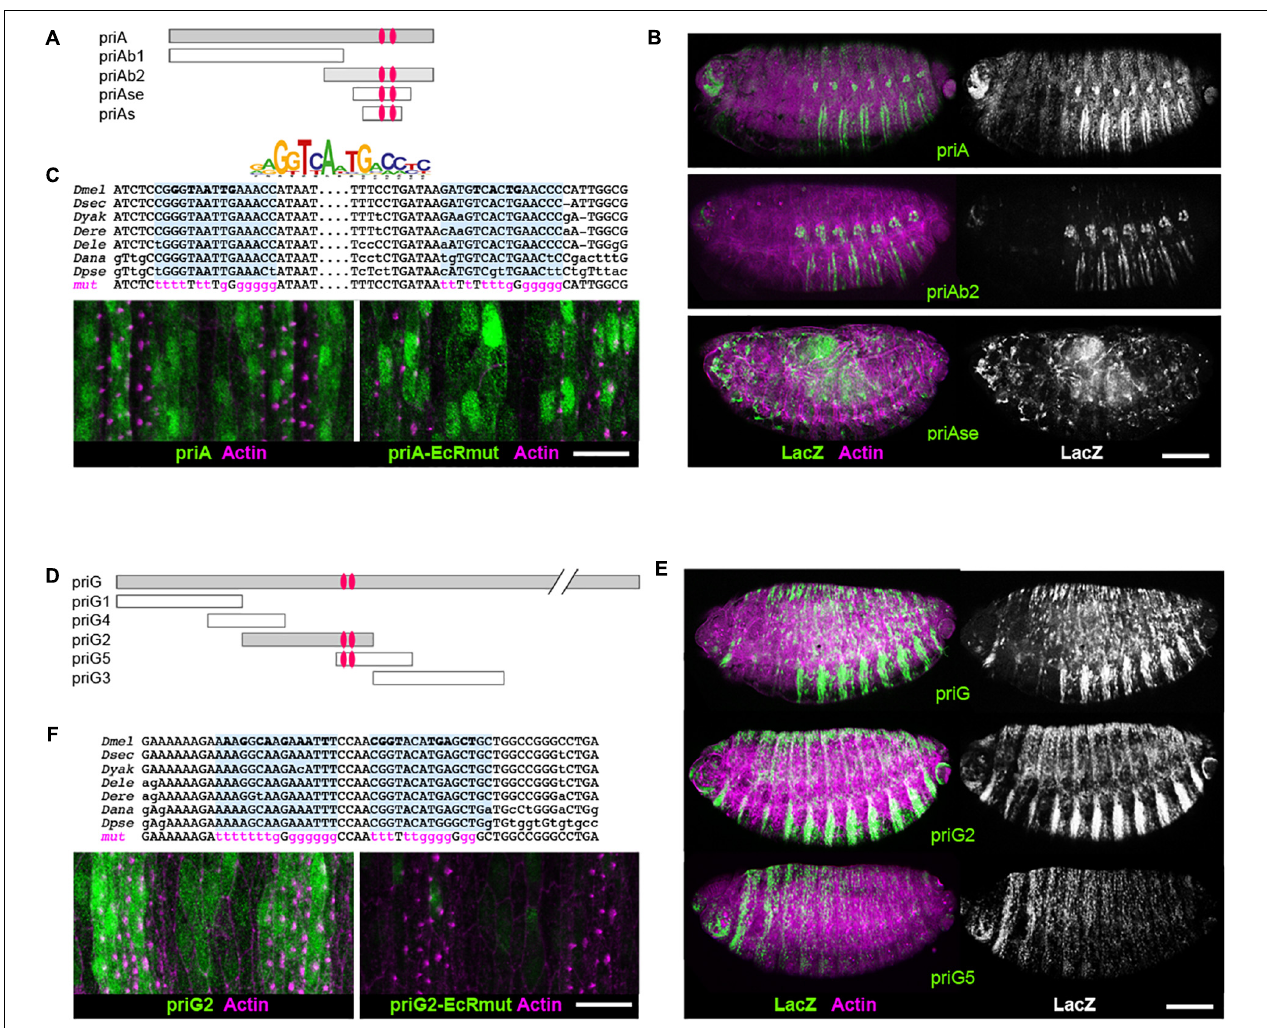
FIGURE 5 | Ecdysone nuclear receptor (EcR) binding sites are required for the activity of pri epidermal enhancers. (A) Scheme of the priA enhancer and its additional subregions that have been tested in lacZ-transgenic reporter lines. Red ovals represent the EcR binding sites shown in panel (C) . (B) Expression of priA , priAb2 , and priAse , as revealed by fluorescence staining (ß-gal is in green, actin in magenta); the right panels show black and white pictures of the ß-gal channel for better contrast. All pictures have been acquired using the same setups. Scale bar is 100 µ m. (C) The logo represents position weight matrix of consensus EcR binding sites. Sequence alignment of EcR binding sites in priA , showing their evolutionary conservation across Drosophila species ( melanogaster , sechellia , yakuba , erecta , elegans , ananassae , and pseudoobscura ). Nucleotides mutated in priA-EcRmut are in magenta. Bottom pictures show confocal microscopy images of the ventral epidermis in stage 15 embryos. GFP (green) reveals the expression of priA and priA-EcRmut enhancers; nascent trichomes accumulate F-actin (magenta) microfilaments. Scale bar is 10 µ m. (D) Drawing of the molecular dissection of the priG epidermal enhancer. (E) Expression of priG-lacZ , priG2-lacZ , and priG5-lacZ as revealed by fluorescence staining (ß-gal is in green, actin in magenta). Scale bar is 100 µ m. (F) Sequence alignment of EcR binding sites of priG2 (top) and confocal microscopy images (bottom) that show the effect of their mutation ( priG2-EcRmut ) on the enhancer activity (ventral epidermis close up). GFP is in green, F-actin in magenta. Scale bar is 10 µ